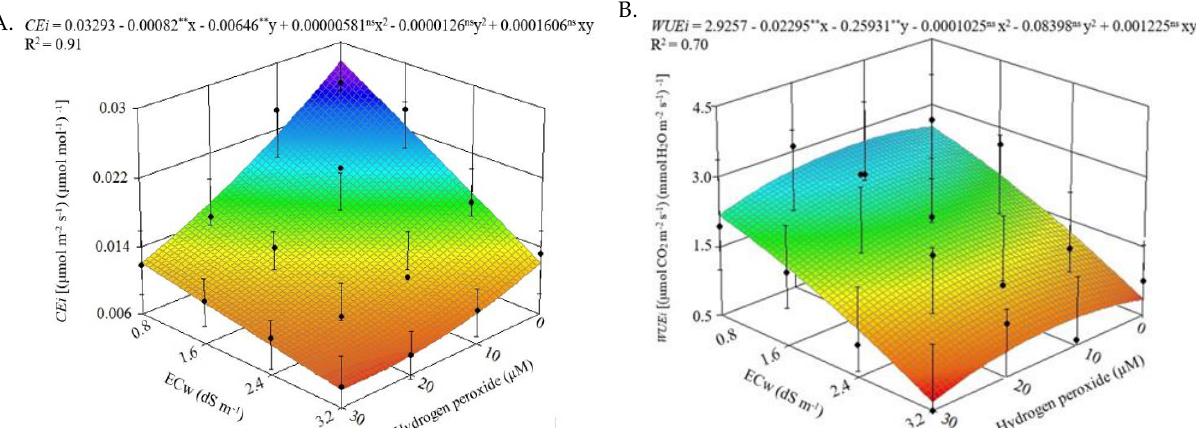
Figure 2. Instantaneous carboxylation efficiency ( CEi ) ( A ) and instantaneous water use efficiency ( WUEi ) ( B ) of soursop plants cv. Morada Nova as a function of the interaction between the irrigation water salinity levels (ECw) and concentrations of hydrogen peroxide (H 2 O 2 ) at 210 days after transplantation. ns and ** are, respectively, not significant and significant at p ≤ 0.01 by the F-test. x and y correspond to ECw and hydrogen peroxide (H 2 O 2 ) concentrations, respectively.